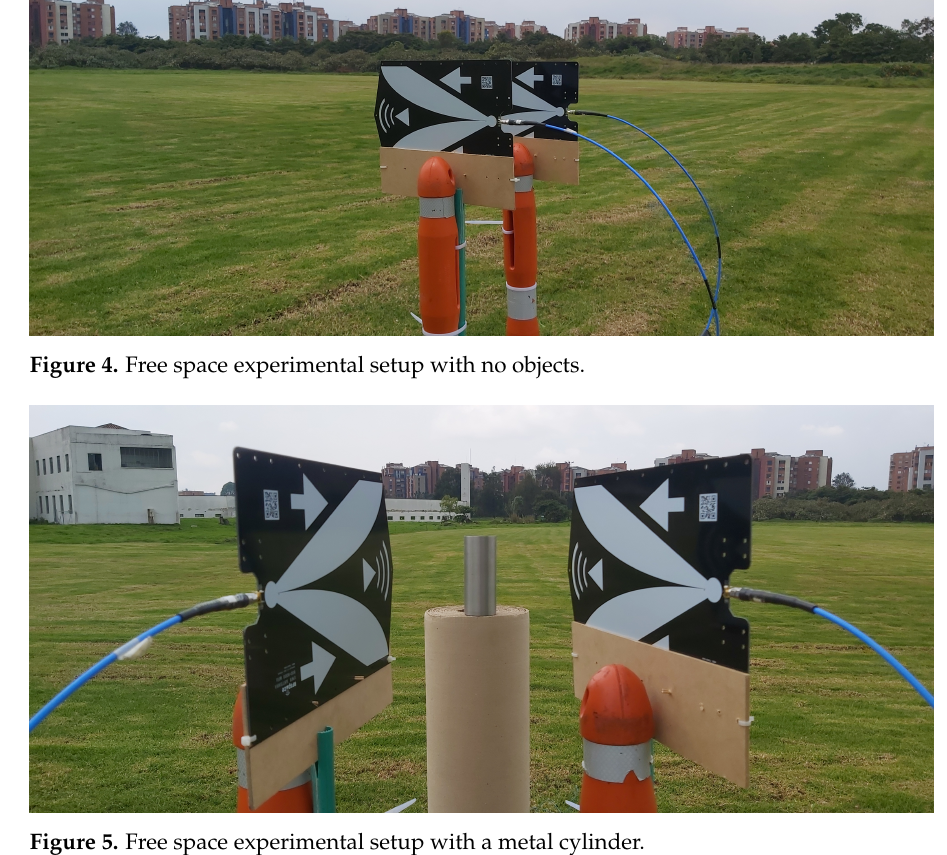
Figure 5. Free space experimental setup with a metal cylinder.